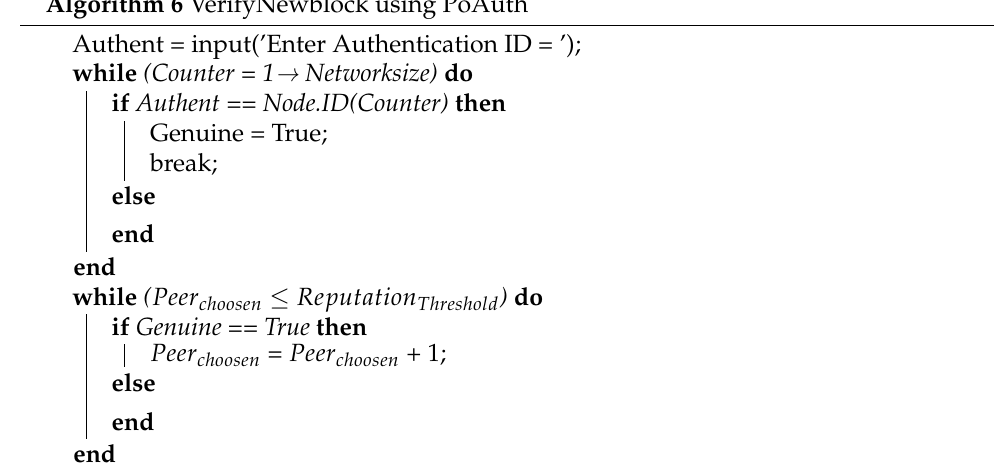
Algorithm 6 VerifyNewblock using